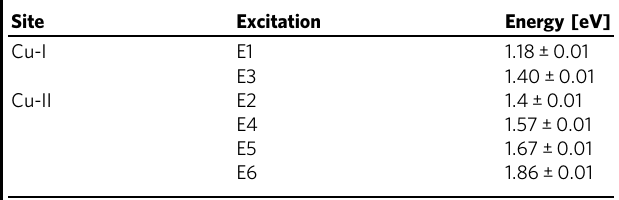
Energies of the Cu-I and Cu-II dd -excitations, extracted from the fi t of the resonant inelastic X-ray scattering (RIXS) measurements. The errors are de fi ned as the standard deviation associated with the least square fi t